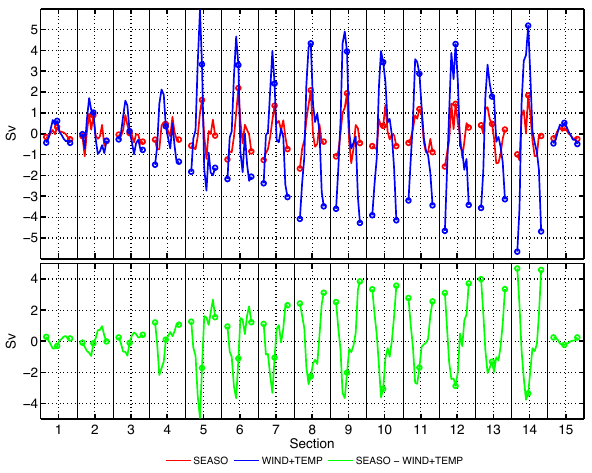
Fig. 13. Same as Fig. 12, but for SEASO and WIND + TEMP simulations.